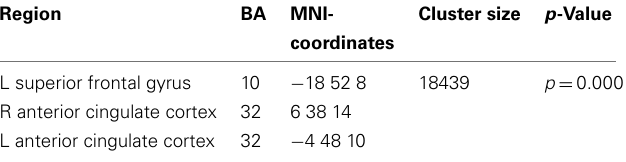
Table 2 | Local maxima of sources showing a power increase (11–15Hz) for preparation for overt reading vs. baseline.